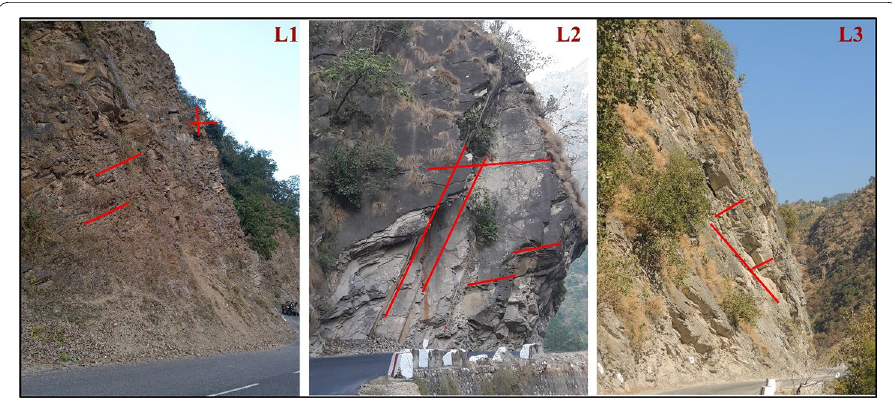
Fig. 2 L1 Indicate the extensive jointed, blocky slope having wedge failure; L2 Cut slope indicate two major joint and overhanging block above highway; and L3 Potential wedge formed by intersection of discontinuity on steep